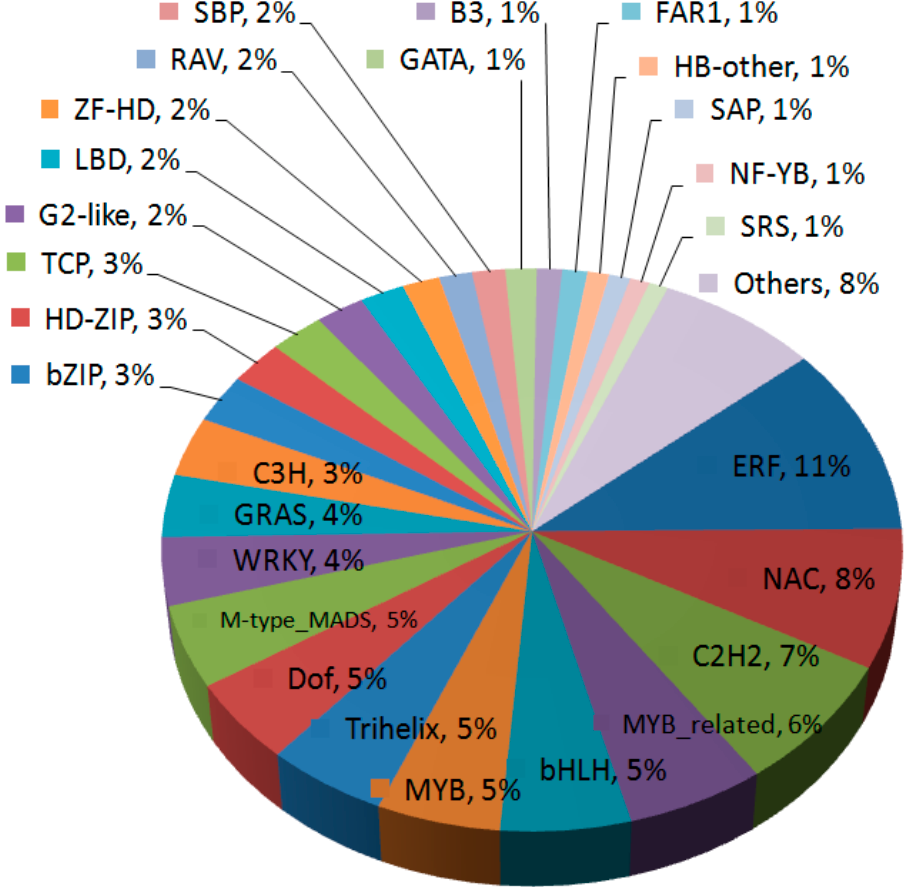
Figure 1. Functional annotation of transcript sequences carrying microsatellites in their functional domains. A total of 1104 SSR-bearing transcript sequences were associated with functional domains of